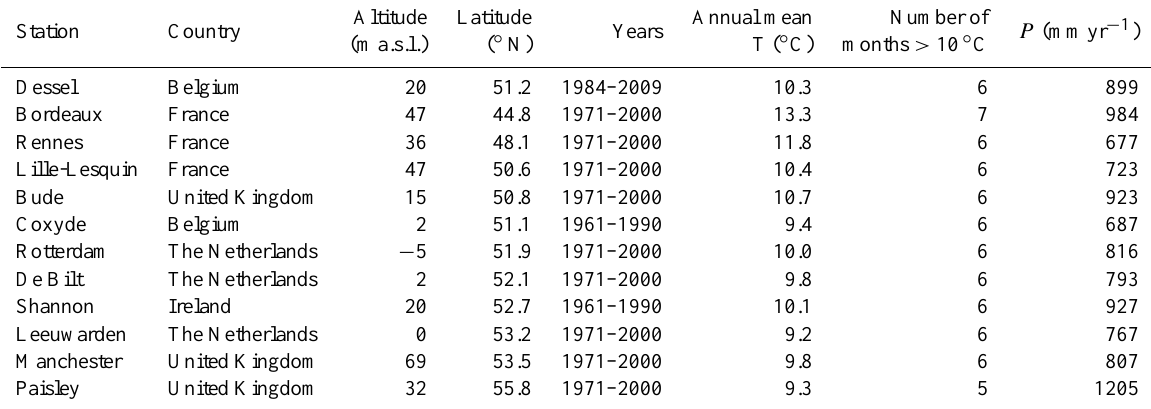
Table A1. Annual temperature and precipitation of a sample of European stations representative of climate variability within the DO class, with the same selection criteria as presented in Sect. 2.2 (sources: IRM-KMI, www.meteo.be; KNMI, www.knmi.nl; Meteofrance, http://climat.meteofrance.com; Met Office, www.metoffice.gov.uk; Met ´Eireann, www.met.ie). Altitude Latitude Annual mean Number of P (mmyr − 1 ) Station Country Years (ma.s.l.) ( ◦ N) T ( ◦ C) months > 10 ◦ C